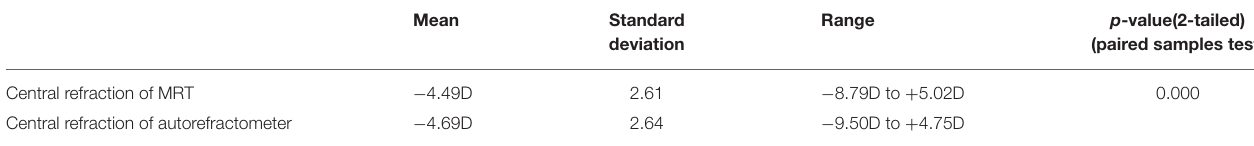
TABLE 2 | Measured Values and Paired T -test Results by Autorefractometer and Multispectral Refraction Topography (MRT).